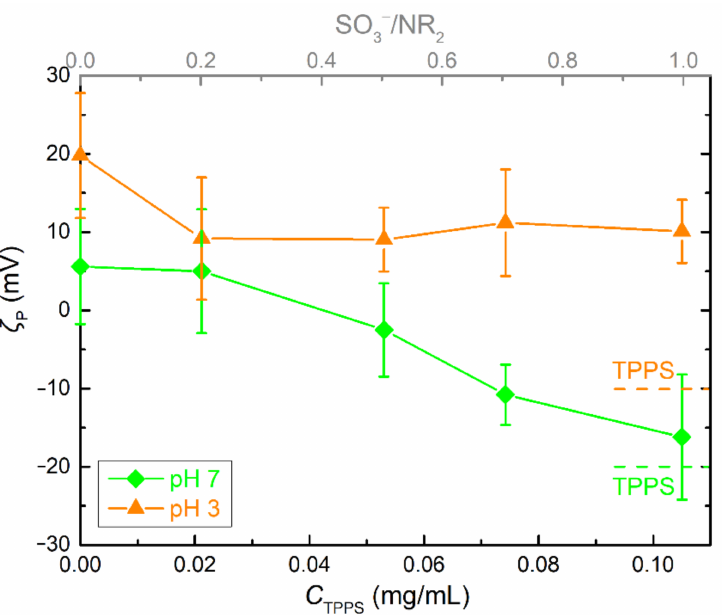
Figure 3. Zeta potential ζ P values for the DHBC/TPPS complex solutions at pH 7 and 3, as a function of C TPPS or SO 3 − /NR 2 ratio. The dashed lines denote the corresponding ζ P values of neat